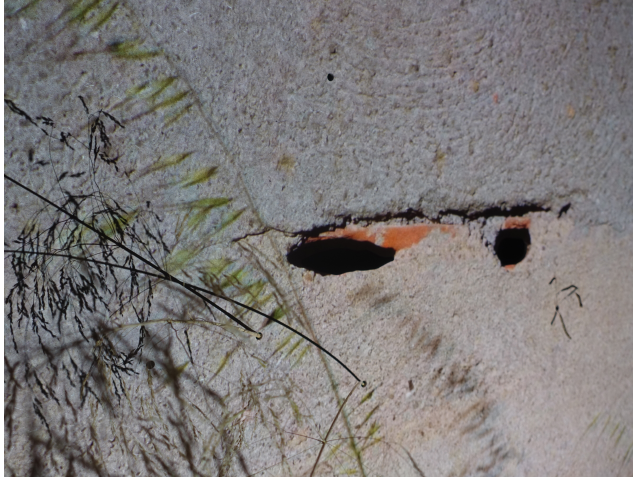
Figure 3: Video-installation IKEBANA (2016) by Alexandre Estrela. View from the private collection of Maria João and Armando Cabral. © Courtesy of Alexandre